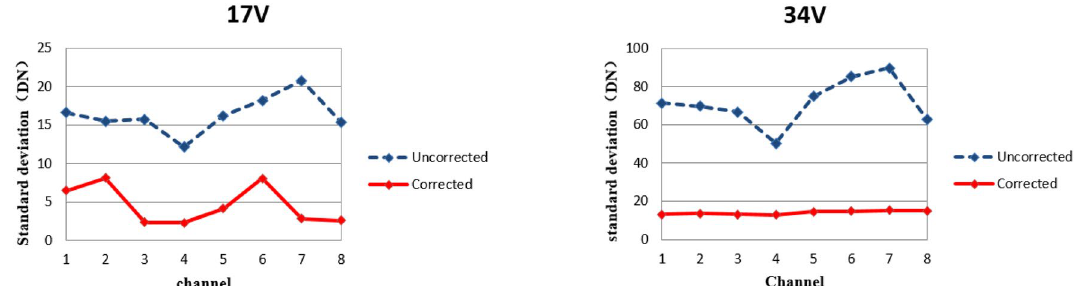
Figure 6. Standard deviation of CCD220 8-channel image before and after correction under different gain